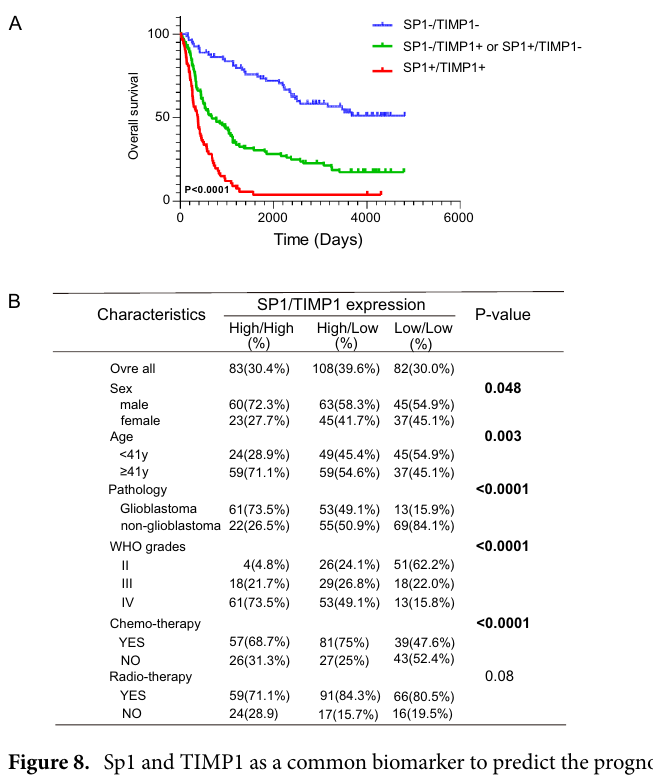
Figure 8. Sp1 and TIMP1 as a common biomarker to predict the prognosis of GBM. ( A ) OS of expression for both TIMP1 and Sp1 from patients in CGGA database. The blue line indicates bothe Sp1 and TIMP1 low expression, red lines indicate bothe Sp1 and TIMP1 high expression, and green lines indicate either Sp1 high expression or TIMP1 high expression. The groups were stratified according to the median expression level of Sp1 and TIMP1. Data were analyzed by log-rank test. ( B ) Relations between Sp1 and TIMP1 expression levels and clinicopathologic characteristics in CCGA database( mRNAseq 325). Significant values are in